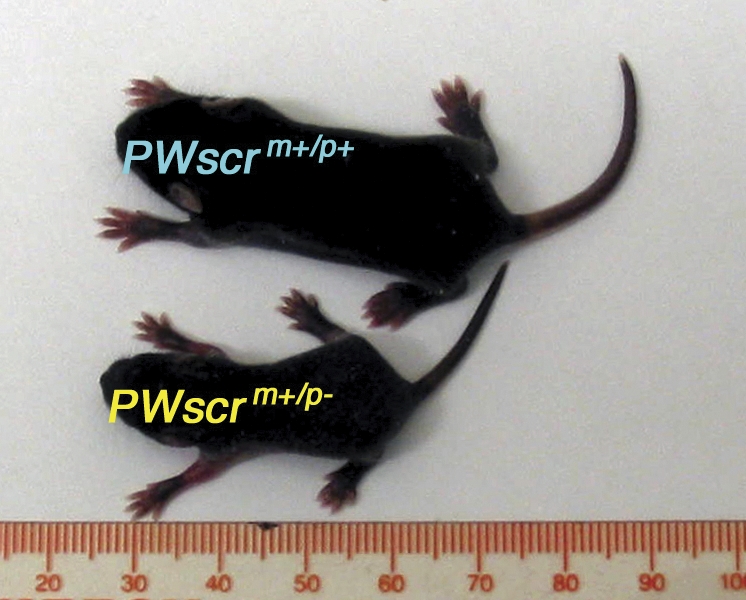
Growth Differences among PWScrm+/p− and PWScrm+/p+ SiblingsRepresentative pair of mice from the same litter at postnatal day 10 (129SV x C57BL/6 genetic crosses).